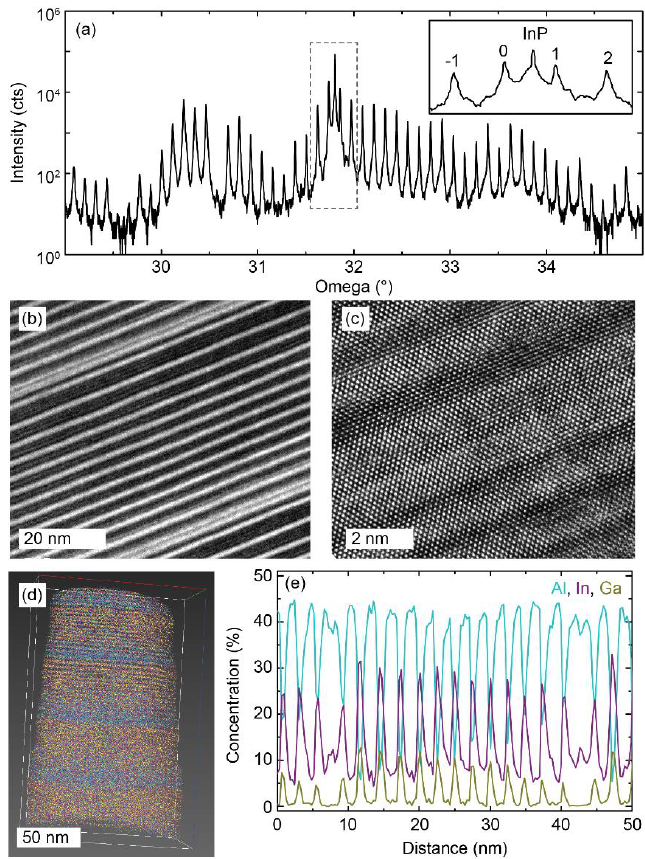
Figure 1. Summary of material characterization techniques for QCLs. ( a ) XRD symmetric scan giving information about the out-of-plane lattice constants, the average periodicity of the superlattice and strain relaxation. The inset displays a zoom of the data inside the gray dashed box, where the substrate peak (InP) and the −1st to 2nd order superlattice peaks are indicated; ( b ) dark-field TEM image resolving the QCL superlattice locally, where the thinnest resolved barrier layer amounts to 5 Å ; ( c ) high-resolution TEM showing the interfaces between individual layers of the superlattice; ( d ) three-dimensional reconstruction of an APT measurement resolving four superlattice periods; and ( e ) averaged one-dimensional concentration profile extracted from the APT data displayed in ( d ).